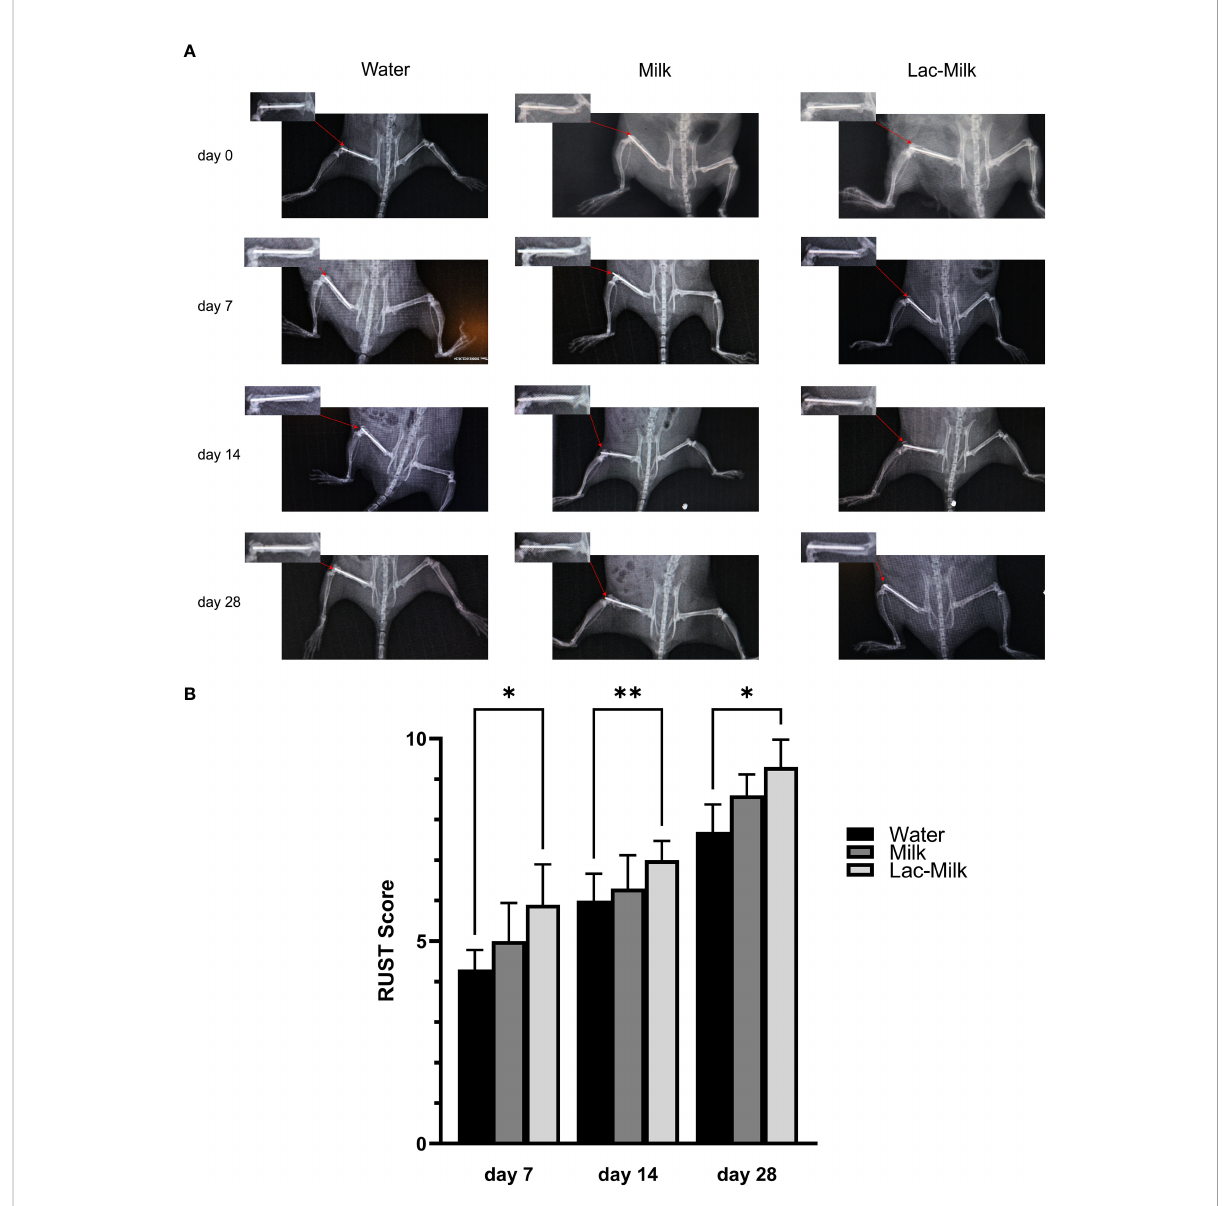
FIGURE 5 Postoperative X-ray images and RUST scores of femoral fractures. (A) Representative images at 1, 7, 14, and 28 days postoperatively. (B) RUST scores at 7, 14, and 28 days postoperatively. *p<0.05,